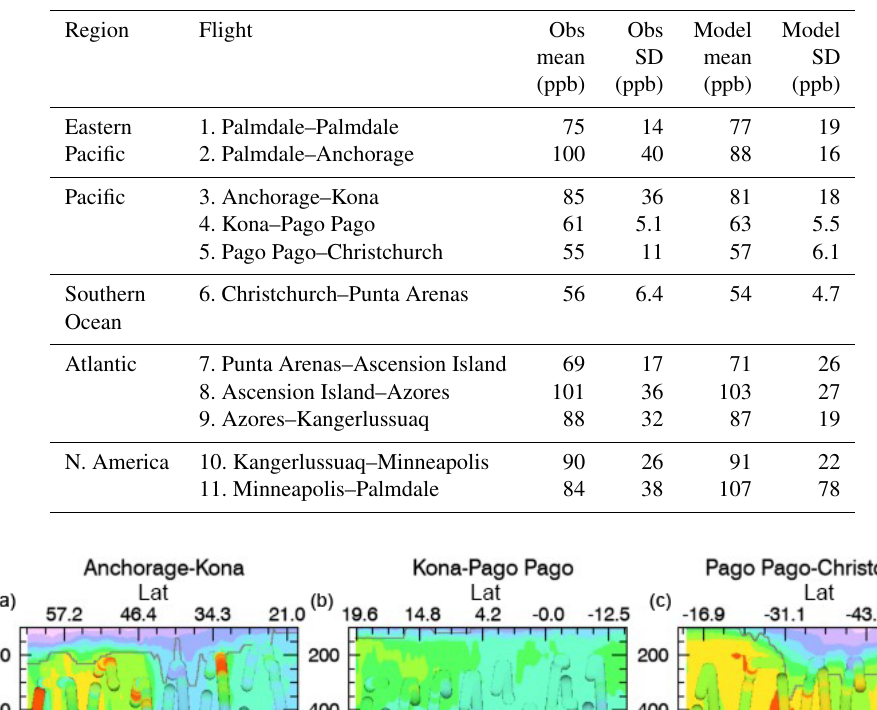
Table 2. Mean and standard deviations in CO along Atlantic and Pacific flight tracks.